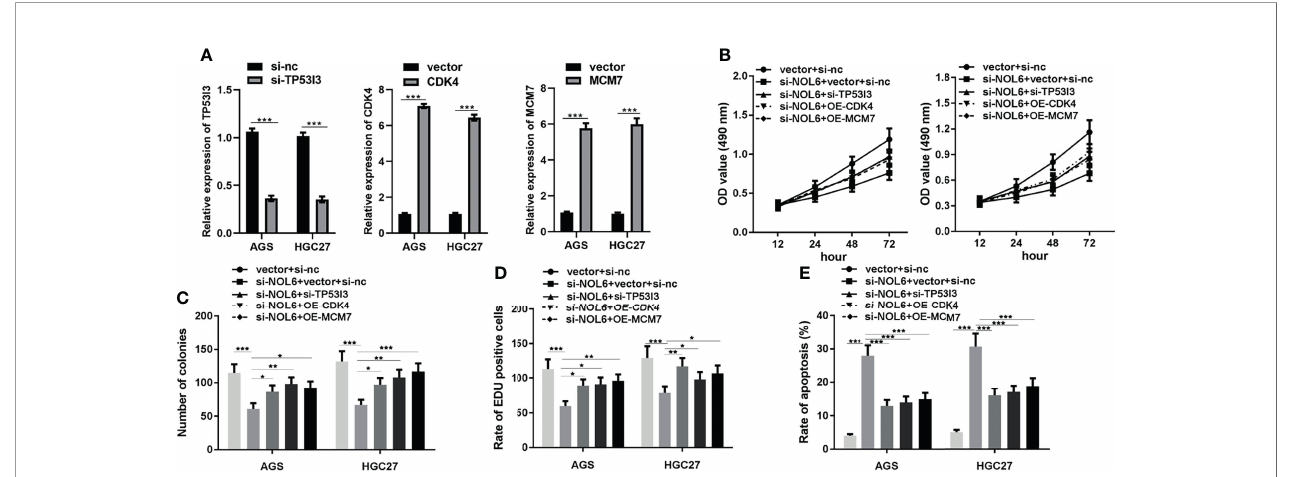
FIGURE 8 | Effect of CDK4, MCM7 and si-TP53I3 on proliferation and apoptosis in NOL6 knockdown AGS and HGC-27 cells. (A) Effect of CDK4, MCM7 and si- TP53I3 transfection on the gene expression of CDK4, MCM7 and TP53I3 in the AGS and HGC-27 cells. (B) Effect of CDK4, MCM7 and si-TP53I3 on the viability of the NOL6 knockdown AGS and HGC cells. (C) Effect of CDK4, MCM7 and si-TP53I3 on the number of colonies in the NOL6 knockdown AGS and HGC cells. (D) Effect of CDK4, MCM7 and si-TP53I3 on the proliferation of the NOL6 knockdown AGS and HGC cells. (E) Effect of CDK4, MCM7 and si-TP53I3 on the apoptosis of the NOL6 knockdown AGS and HGC cells. (*p < 0.05, **p < 0.01, ***p <